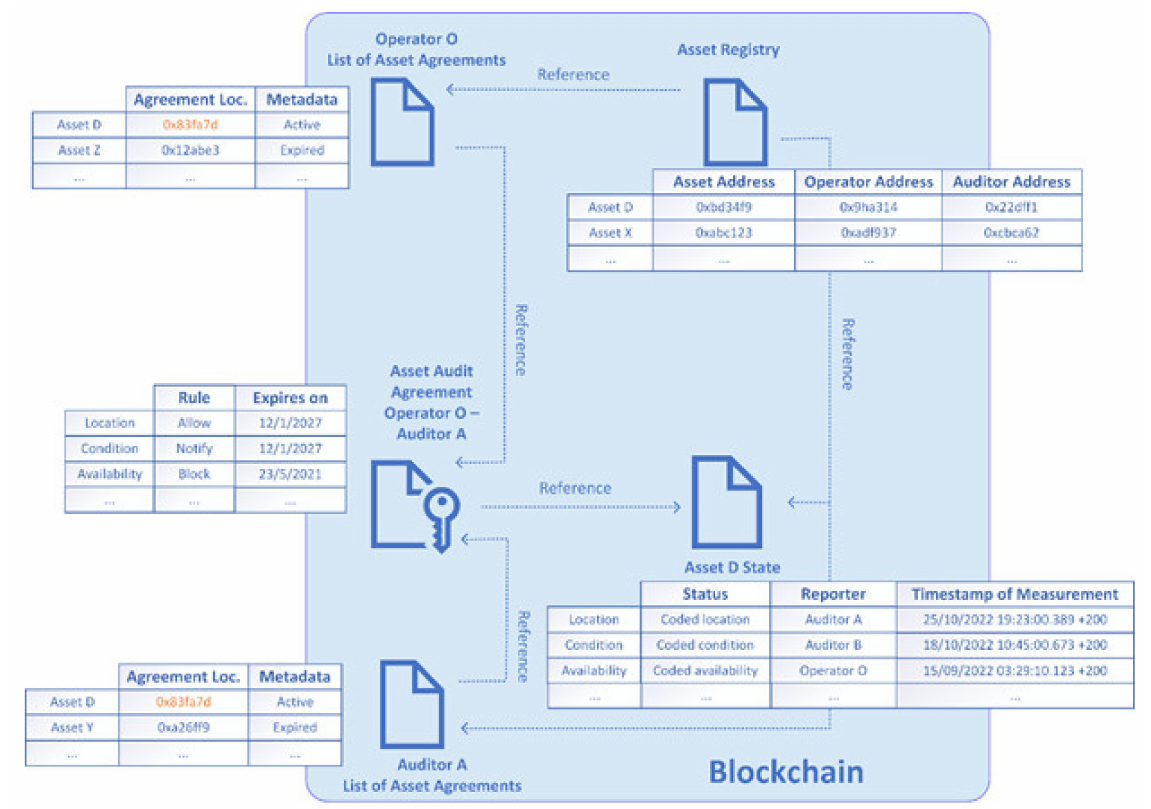
Figure 2. Smart contract-based data model.